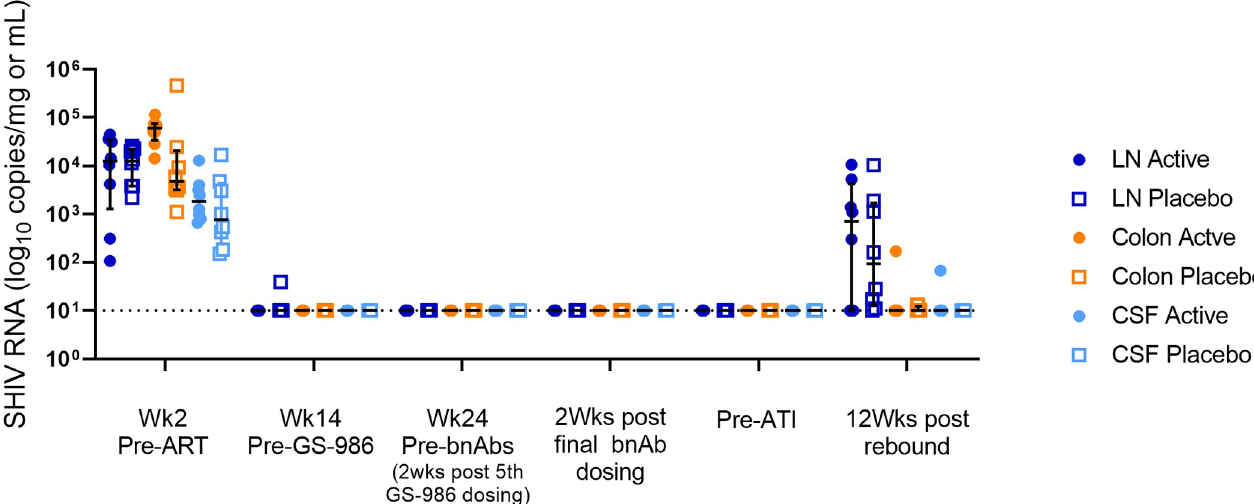
Fig 3. Tissue SHIV RNA levels. Lymph node (blue), colon (orange) and cerebral spinal fluid (CSF, pale blue) SHIV RNA levels were high in the active (filled circle) and control (open square) animals at wk 2 post inoculation. SHIV RNA levels became undetectable in the tissues in all but 1 animal by wk 14 and remained undetectable in all animals whilst on ART. Lines and error bars represent median and interquartile range (IQR). Dotted lines represent LOQ of SHIV RNA assay, 10 copies/mg for lymph node and colon tissues and 10 copies/mL for CSF.